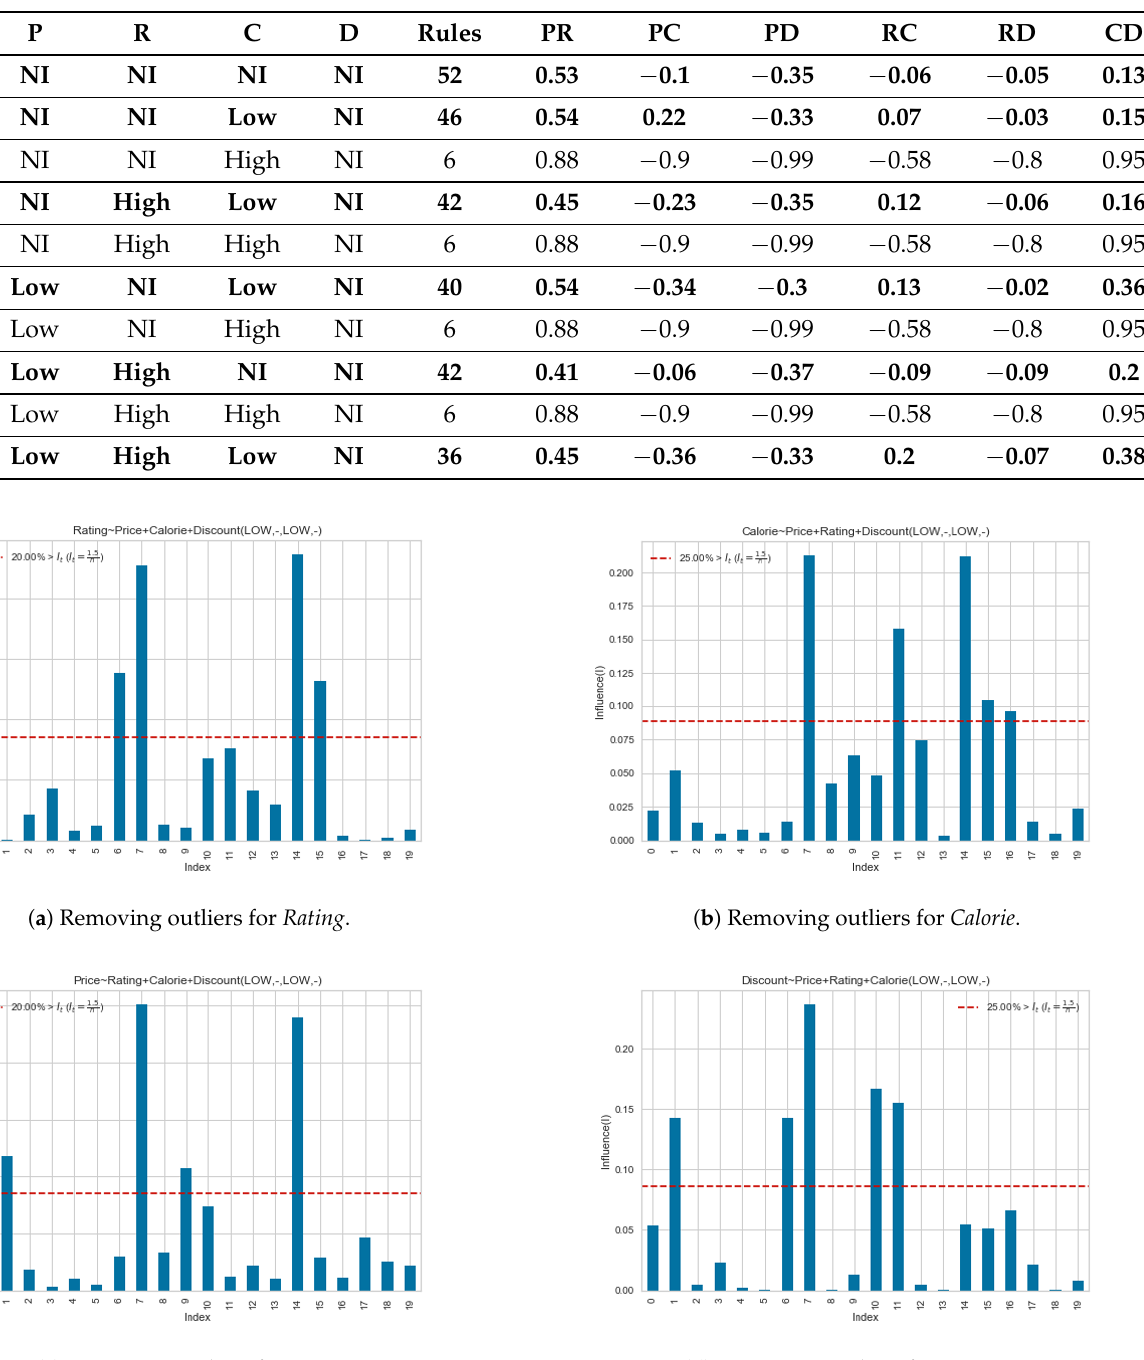
Figure A1. Outlier detection based on Cook’s distance. The red lines represent the cut-off